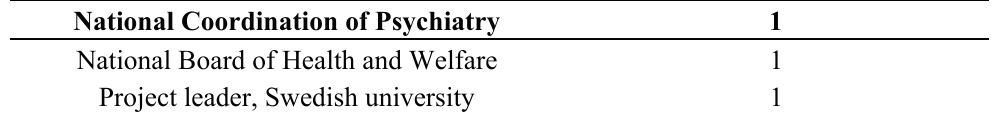
Table 1. Descriptions of the collected data. Interviews with actors at the national level.